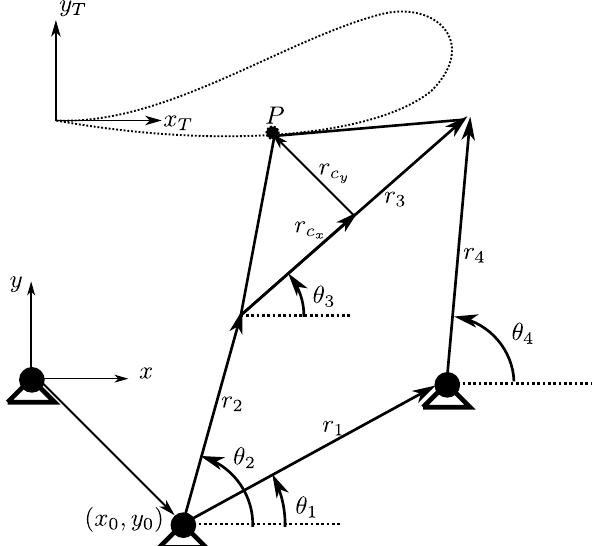
Figure 3. four–bar linkage